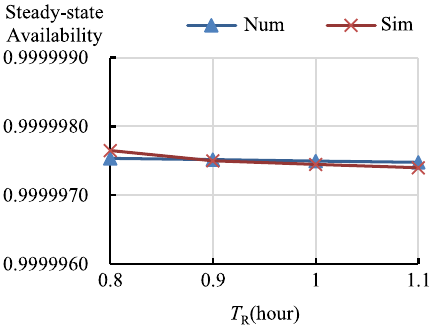
Fig. 5 Comparison of numerical and simulation results for steady- state availability